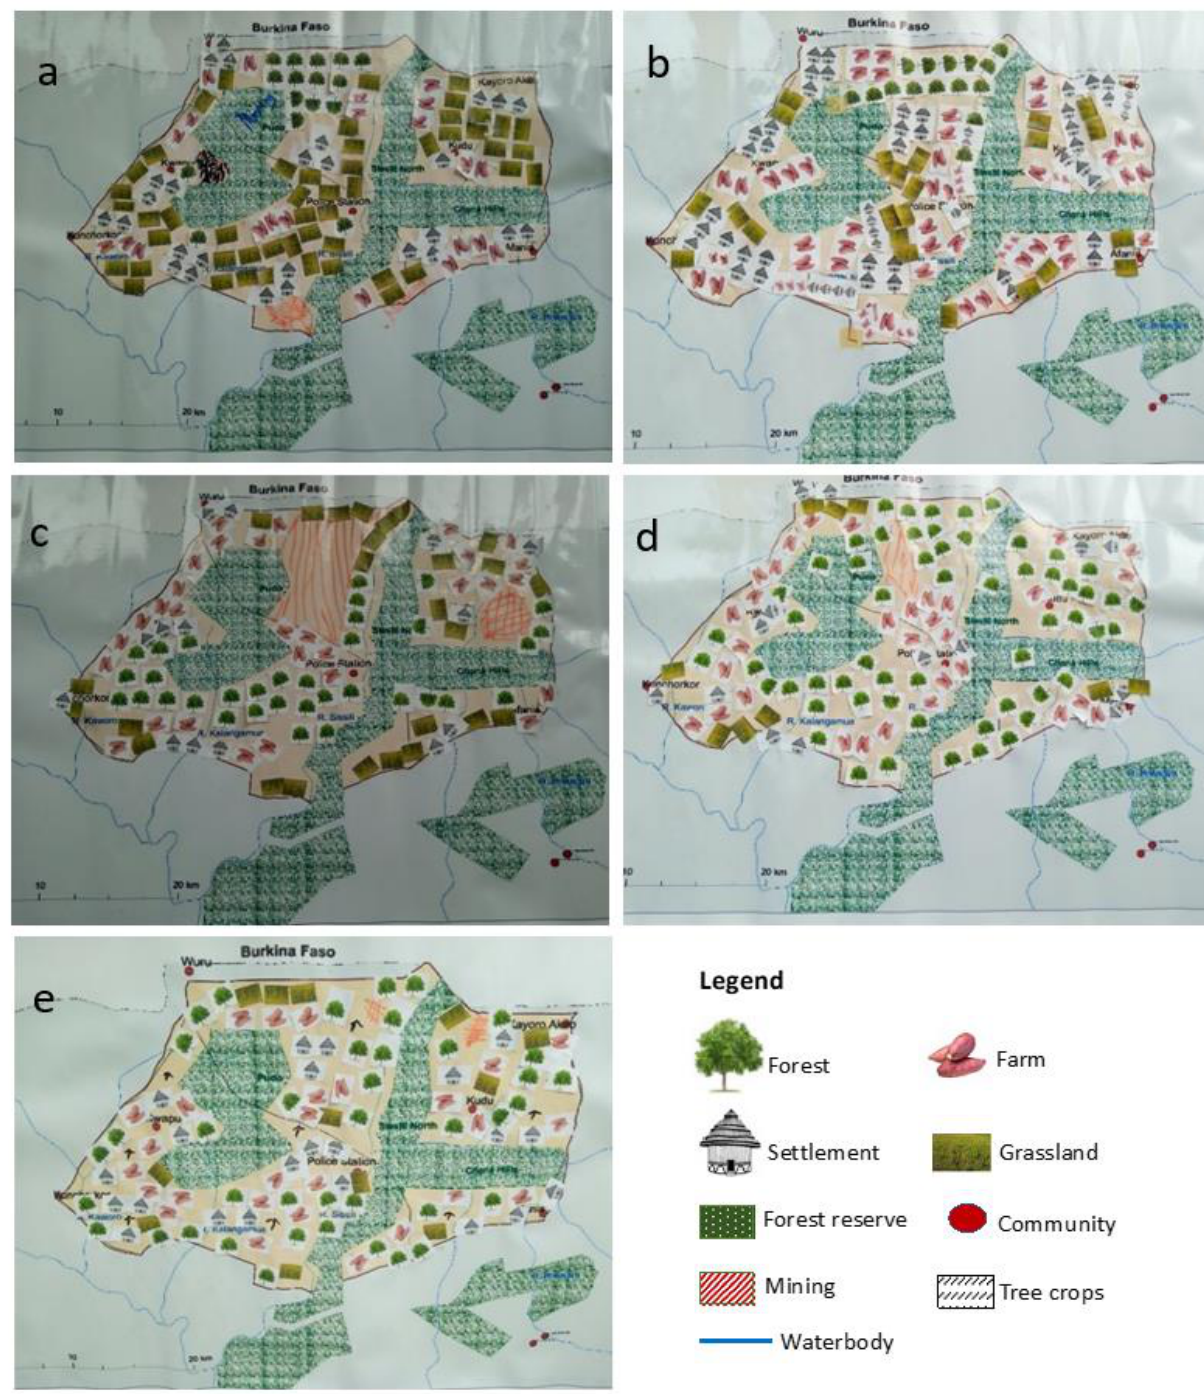
Figure 10. Participatory maps of current and desired futures of the SKGK landscape by community actors ( a = current; b = future), institutional actors ( c = current; d = future), and the consensus view of the future landscape ( e ).